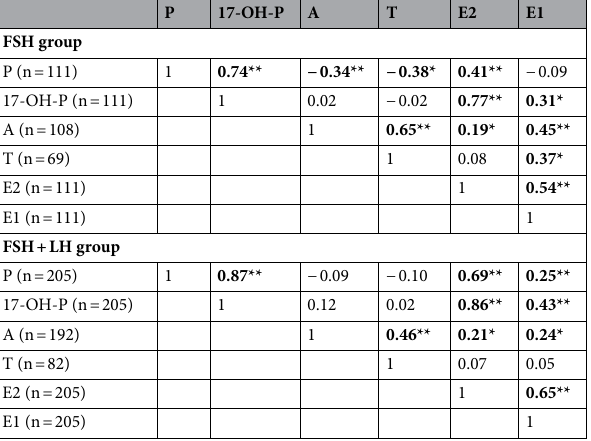
Table 3. Correlation (reported as Spearman’s rank correlation coefficient) among FF steroid hormone levels in the two groups of ovarian stimulation (FSH and FSH + LH). *p < 0.05, **p < 0.001. In bold statistically significant differences.